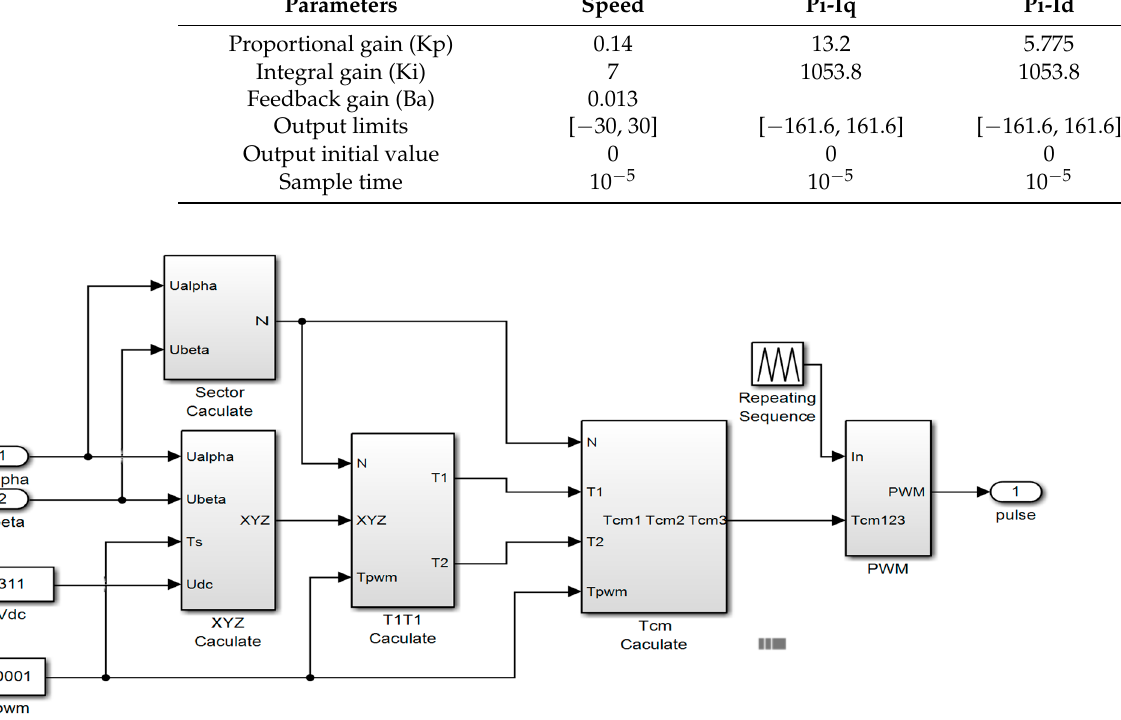
Figure 4. Simulation model of SVPWM control algorithm.